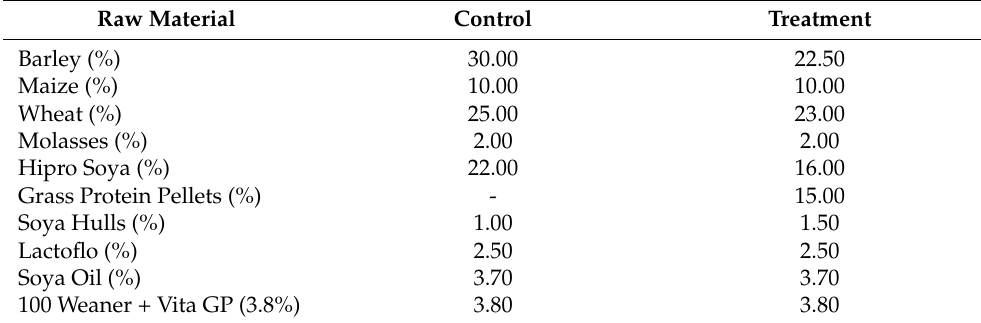
Table 2. Composition of control and treatment feed.